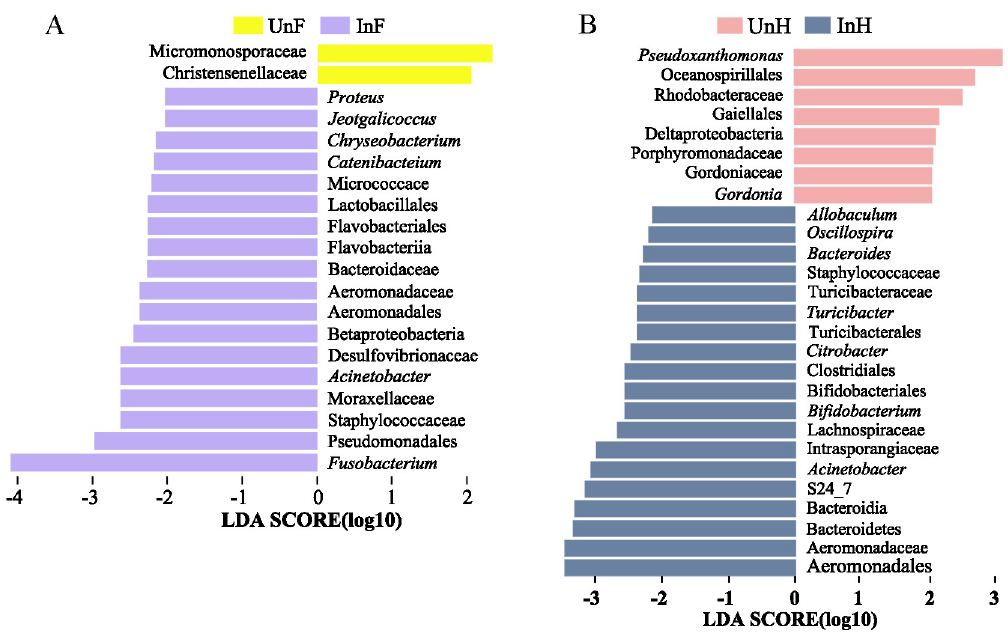
Fig 8. Bacterial taxa with significant differences (LDA score > 2.0) in the relative abundance identified by the Lefse analysis in UnF and InF groups (A), and UnH and InH groups (B). UnF, uninfected with S . acheilognathi in the foregut of grass carp; UnH, uninfected with S . acheilognathi in the hindgut of grass carp; InF, infected with S . acheilognathi in the foregut of grass carp; InH, infected with S . acheilognathi in the hindgut of grass carp.